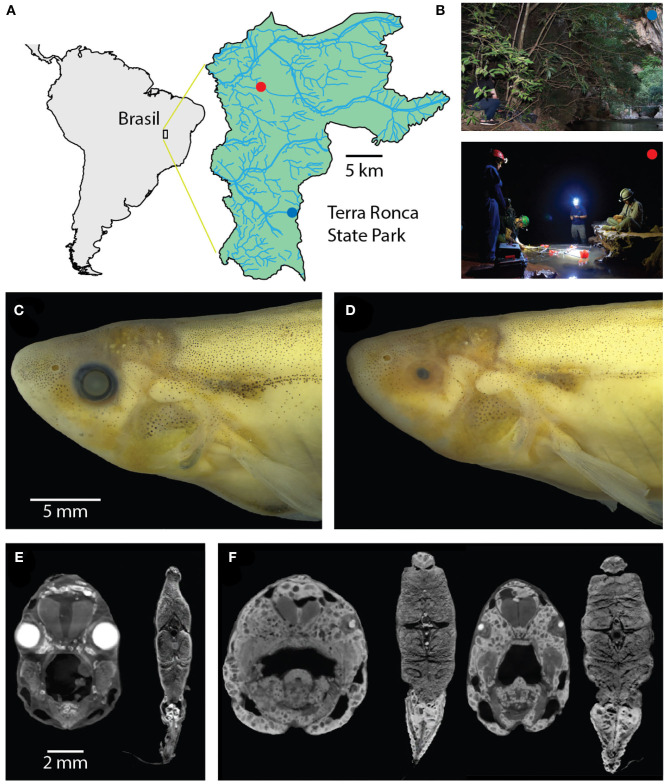
Surface and cave Eigenmannia. (A) Study sites are in a clear water system in the Rio da Lapa karst region in Goiás, Brazil. (B) Top, the surface Eigenmannia site is in the entrance of the Rio da Lapa cave. Bottom, the cave Eigenmannia are found in the São Vicente II cave. (C) Surface Eigenmannia have well-developed eyes and distinctive markings. (D) Cave Eigenmannia have poorly developed or missing eyes and reduced pigmented features. diceCT imaging reveals the differences in eye sizes and a potential difference in the relative size of electric organs. (E) Coronal sections through the head and mid-body of a surface fish and (F) two cavefish (dorsal is up). Large, bright cells in the caudoventral coronal sections appear relatively larger in the cave vs. surface species.